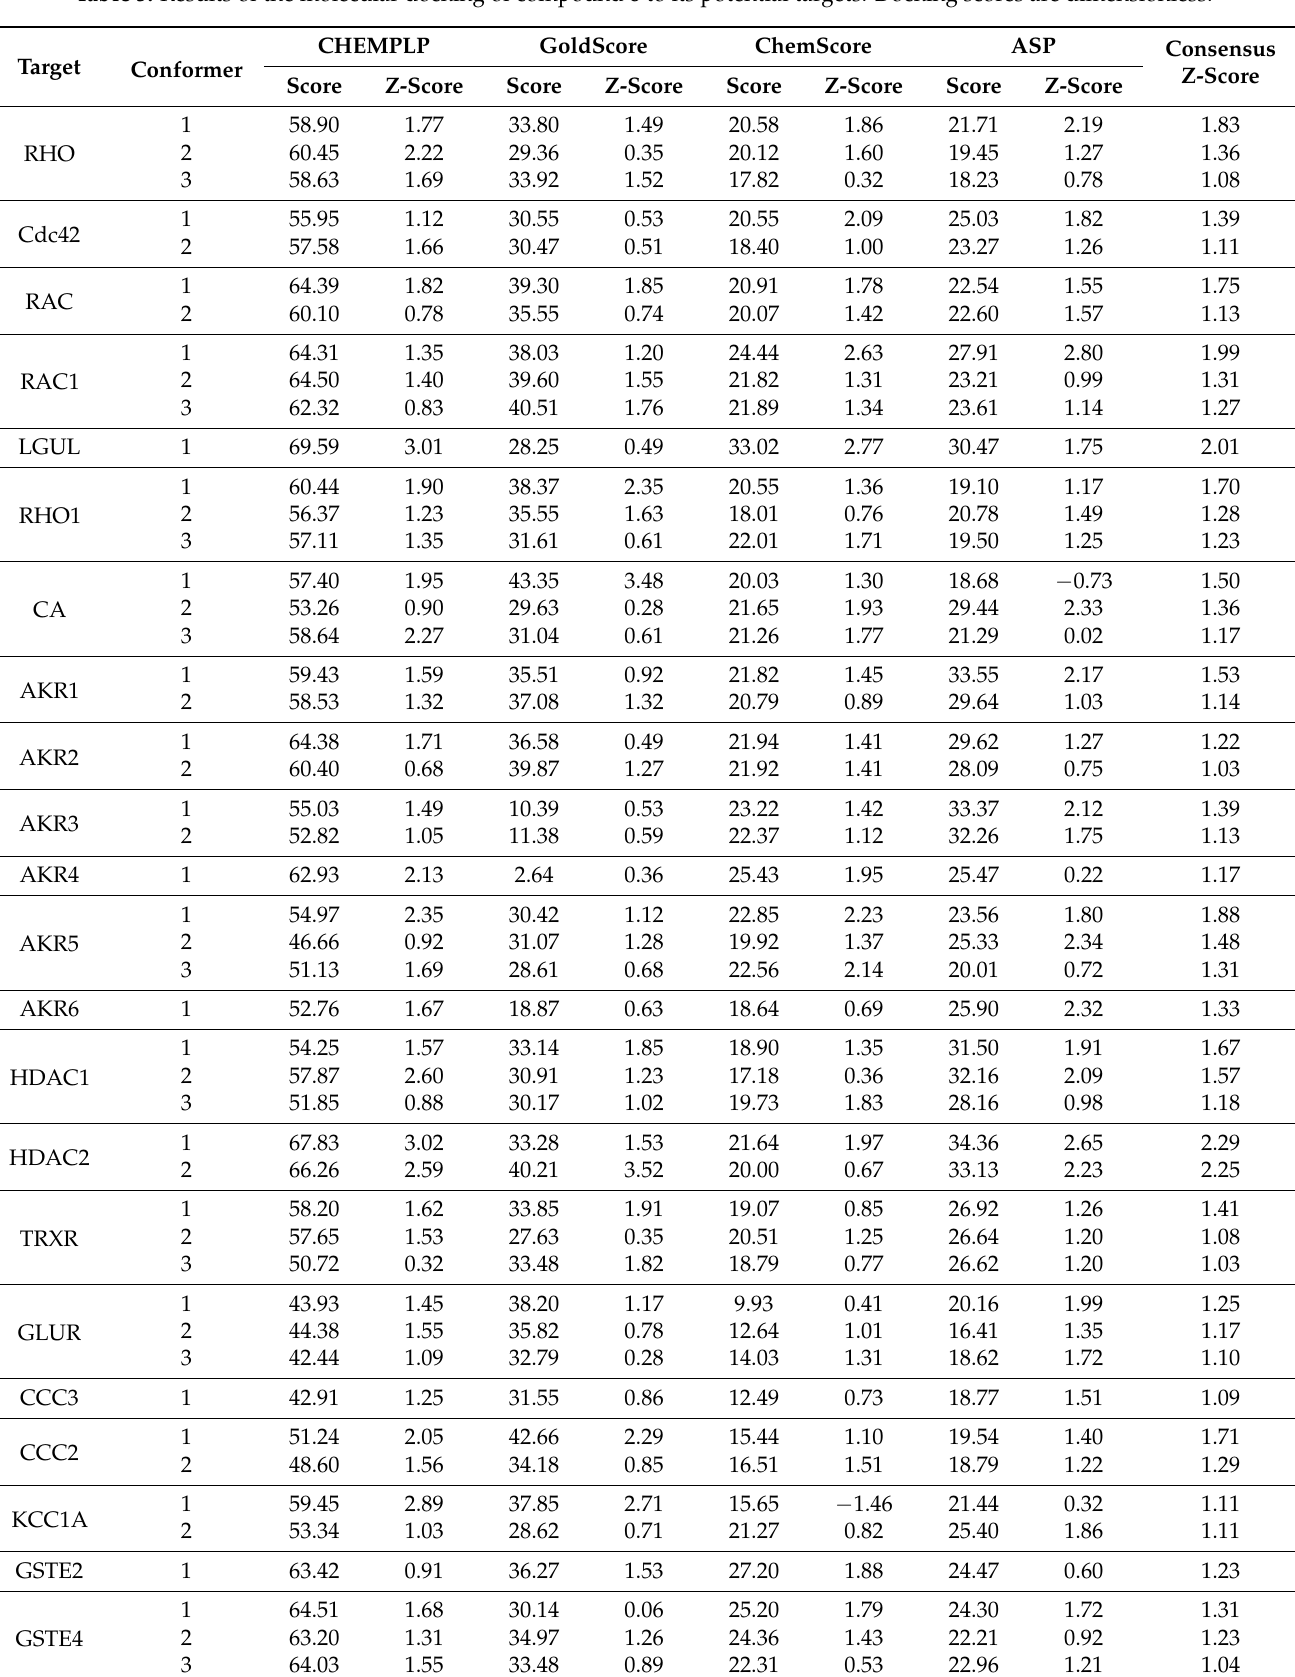
Table 3. Results of the molecular docking of compound 8 to its potential targets. Docking scores are dimensionless. Target